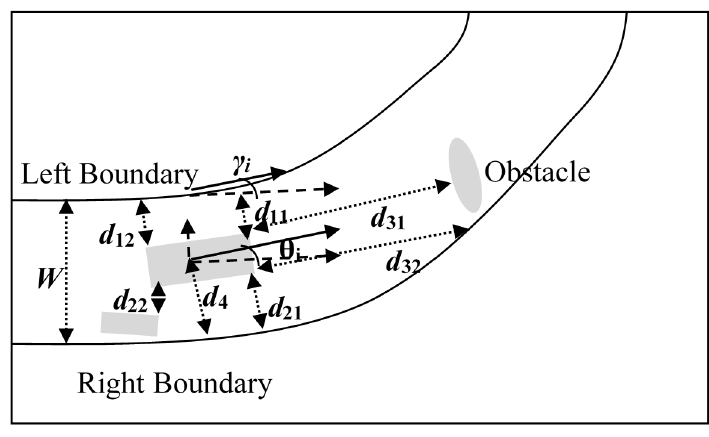
Figure 2. Various inputs to the fuzzy based